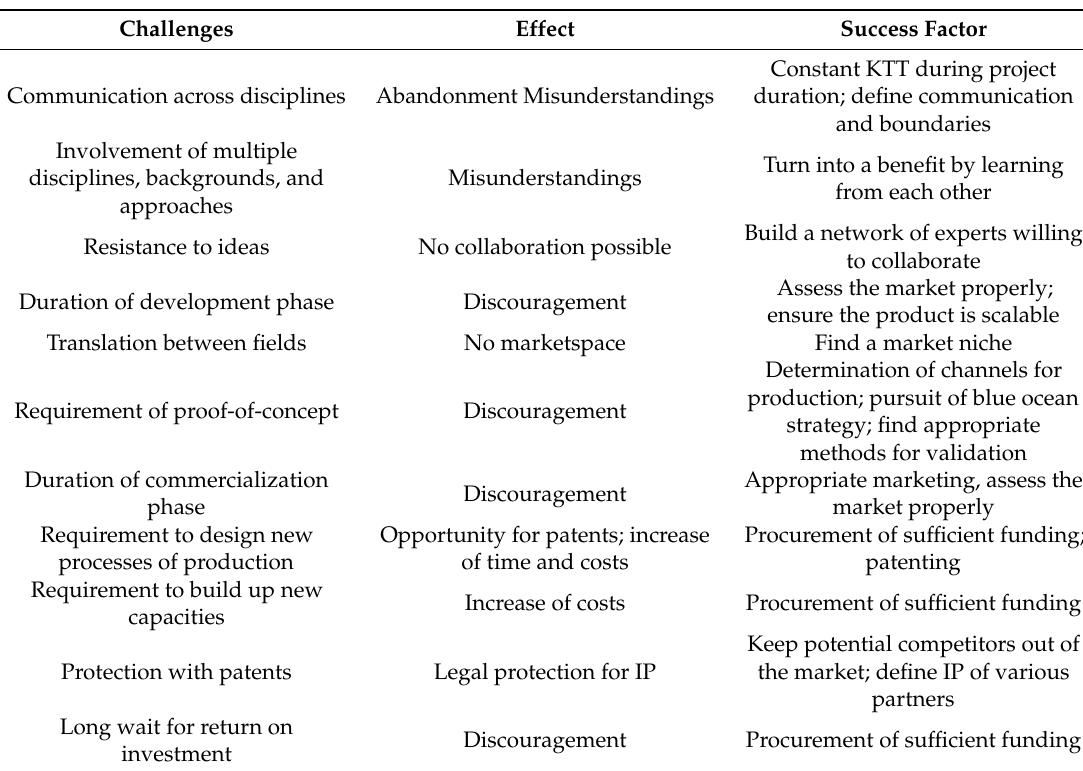
Table 3. Challenges, effects, and key factors of success based on reports from developers in BID